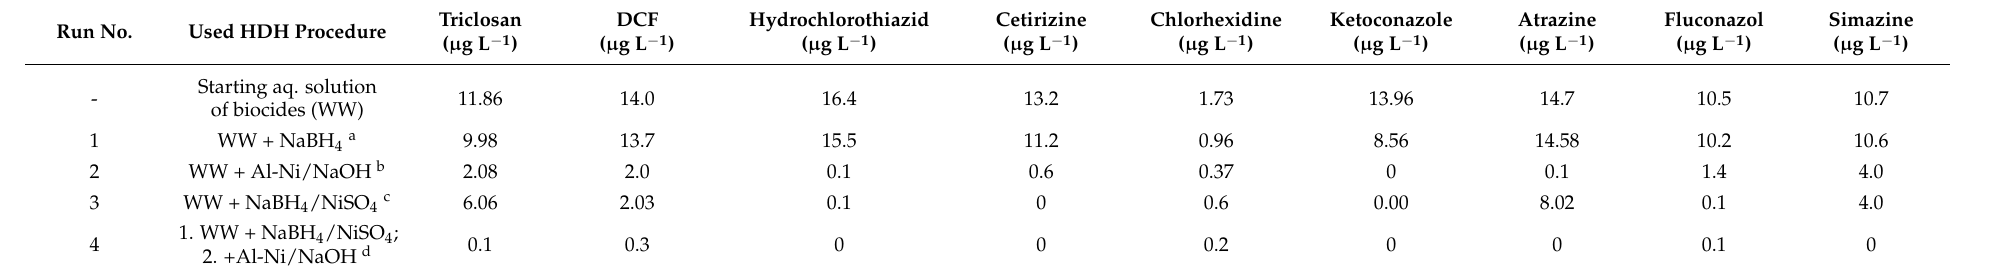
Table 4. A comparison of removal efficiency of 9 aromatic or heterocyclic halogenated biocides using different reductants determined using HPLC-MS (see the Supplementary Material for more